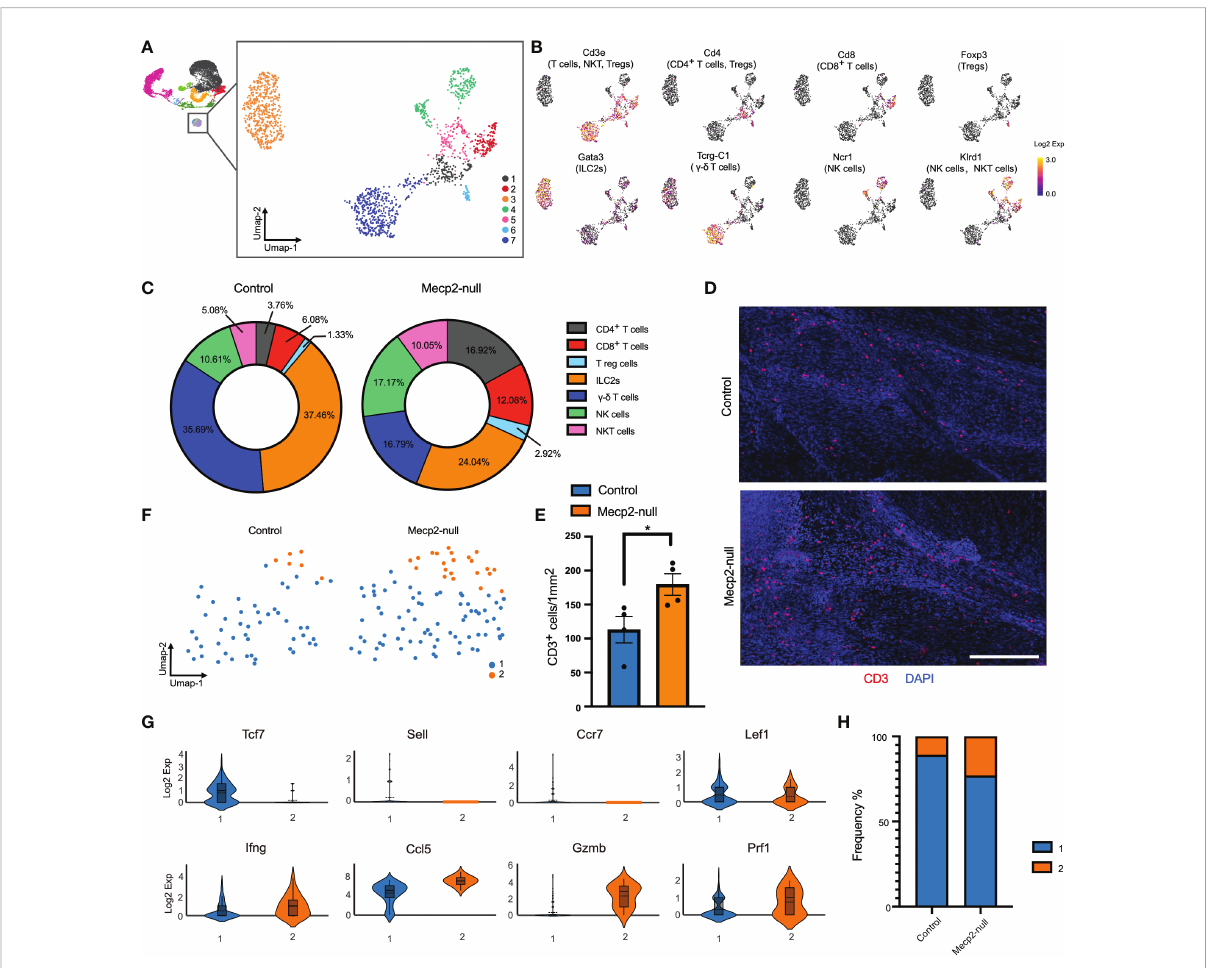
FIGURE 4 Increased T cell cytotoxicity in Mecp2-de fi cienct mice. (A) Umap plot showing the distributions of seven clusters for T cells, NK cells, and ILC2s. (B) Umap plots showing the expression of signature genes for CD4 + T, CD8 + T, Tregs, g - d T, ILC2s, NK, and NKT cells. (C) Percentages of each cell population among the total meningeal T cells, NK cells, and ILC2s in control and Mecp2 -null mice. (D) Representative confocal images of CD3 (red)-positive cells in the dura maters of control and Mecp2 -null mice. Scale bars: 250 m m. (E) Quanti fi cation of the density of CD3-positive cells in the dura maters of control and Mecp2 -null mice (n=4 per group). Data represent the mean ± SEM. *p < 0.05, P = 0.0371, two-tailed unpaired t test. (F) Umap plots indicating the two sub-clusters of CD8 + T cells. (G) Violin plots representing the expression of resting state (top row) and cytotoxicity/activated (bottom row) related markers. (H) Frequency of two sub-clusters of CD8 + T cells in control and Mecp2 -null